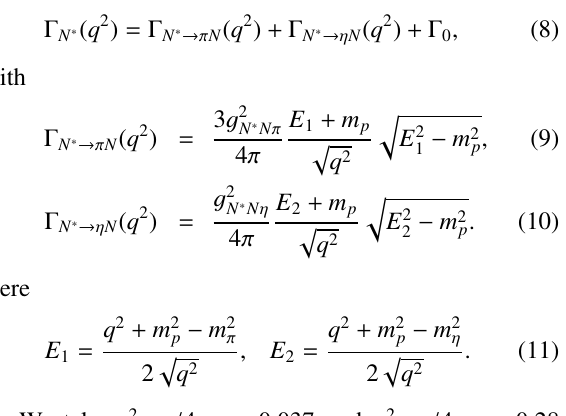
Figure 4. Quark level diagram for Λ + hadron level diagram for Λ +